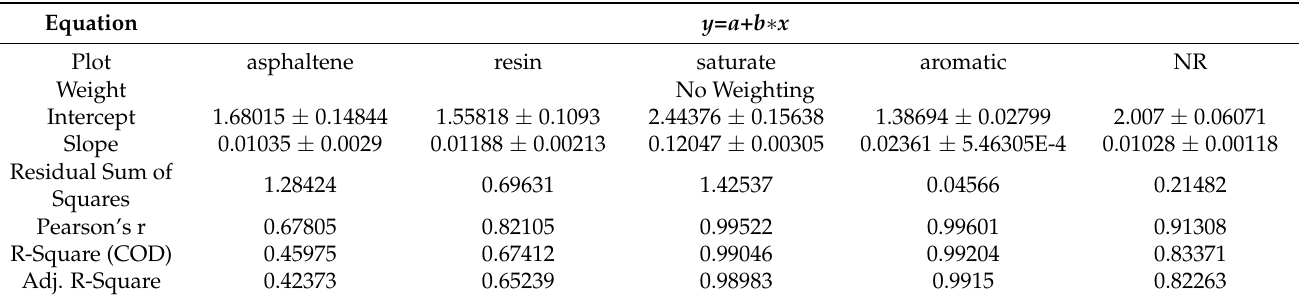
Table 5. Data analysis of MSD for NR-modified asphalt.